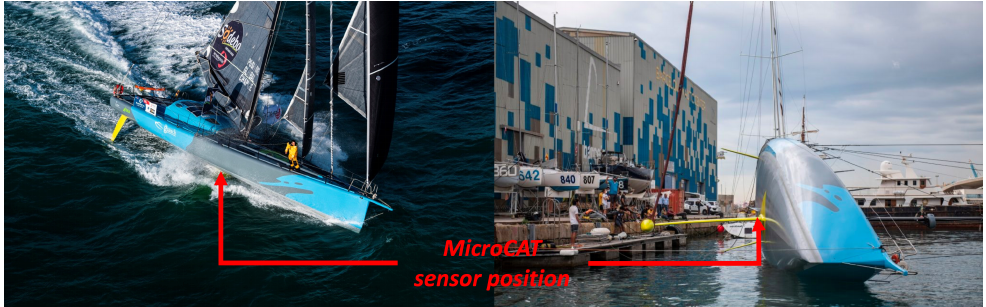
Figure 3. Position of conductivity-temperature sensor that was installed onboard the One Ocean One Planet